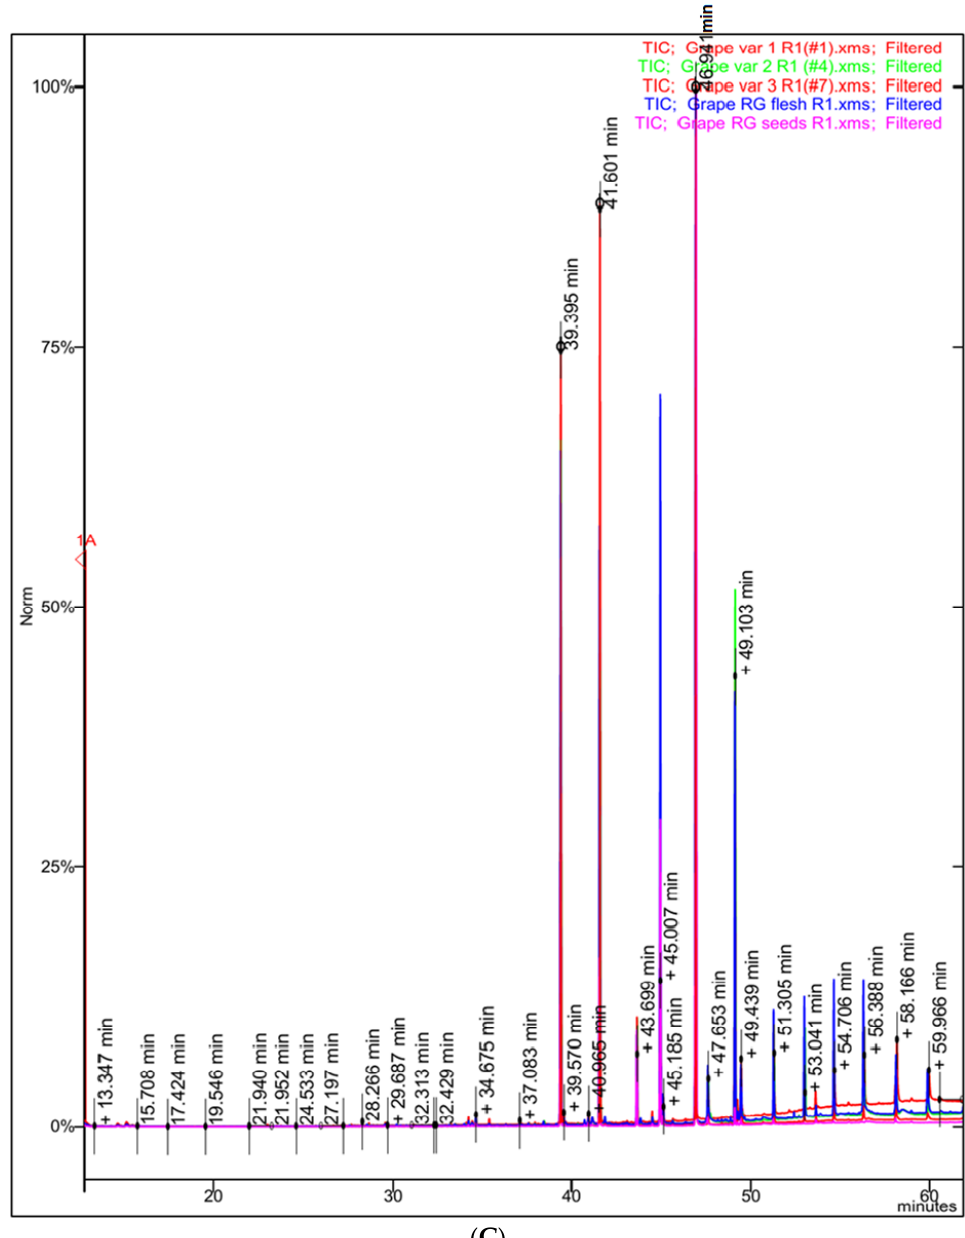
Figure 2. Chromatograms obtained from HPLC and GC/MS. ( A ) Chromatogram of phenolic compounds identified in Red globe grape extract at 280 nm. ( B ) HPLC chromatogram of a mix of phenolic compound standards detected at 280 nm. Rt 7.8 Protocatechuic acid; Rt10.7 Catechin; Rt 11.78 4-Hydroxybenzoic acid; Rt 13.197 Vanillic acid; Rt 13.693 Epicatechin; Rt 14.830 3-Hydroxybenzoic acid; Rt 17.927 Vanillin; Rt 18.850 p -Coumaric acid + syringaldehyde; Rt 20.10 Ferulic acid; Rt 22.8 Benzoic acid; Rt 24.7 Salicylic acid; Rt 26.7 Genistein. ( C ) GC/MS total ion chromatogram of the fatty acid methyl esters extracted from the grape varieties (Flame, Autumn Royal, Sweet Scarlet, Red Globe pitted, and seeds).